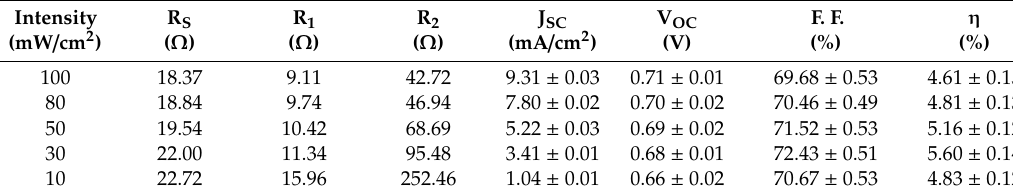
Table 3. Parameters of DSSC based on TANP.